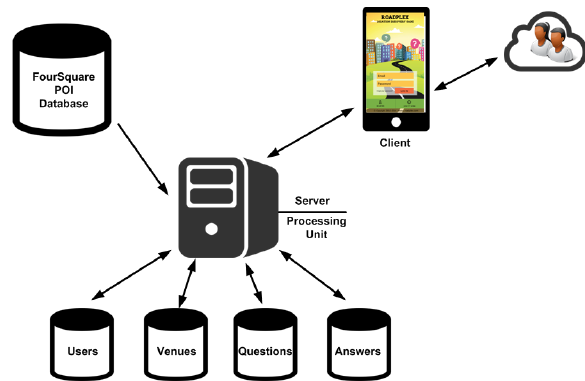
Figure 1. RoadPlex data interactivity diagram